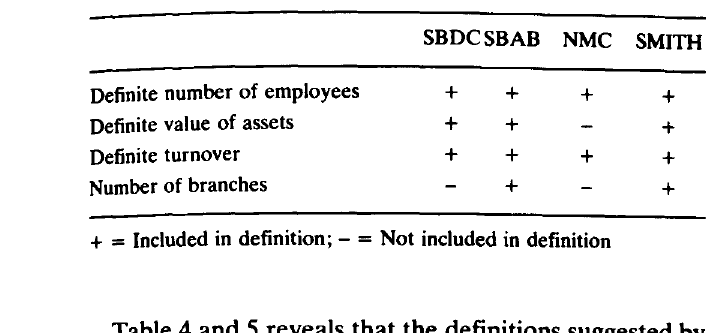
Table 5 Quantitative guidelines for small business